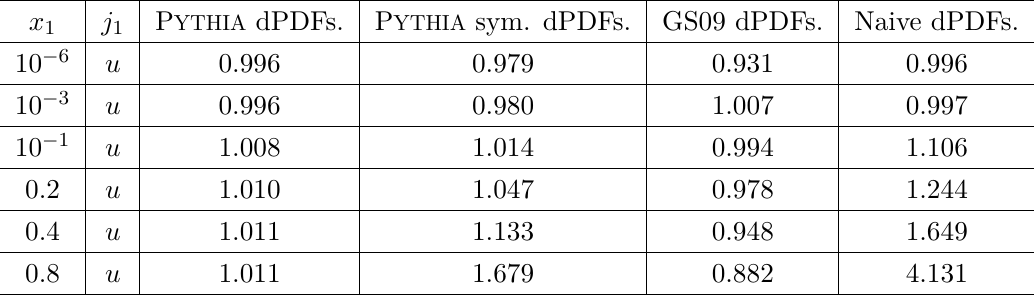
Table 4 . Test of the momentum sum rule for the symmetrized P YTHIA